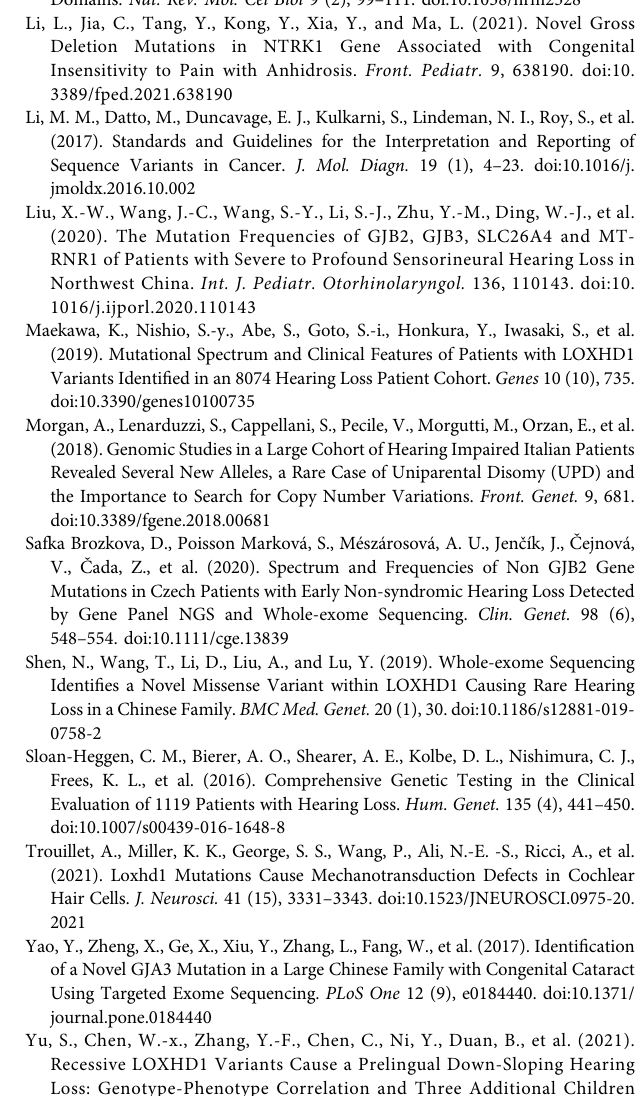
Supplementary Figure S1 | Scatter plots of hearing phenotypes of 21 patients after grouped by variant location and variant severity. Type1: grouped by variant location; Type2: grouped by variant severity. Supplementary Figure S2 | Proportions of different types of variation of LOXHD1 both worldwide and in China. (A) Proportions of different types of variation of LOXHD1 worldwide. Types of variation were broken down as missense, nonsense, frameshift,splice-site,intronicand synonymous. (B) Proportionsofdifferenttypesof variation of LOXHD1 in China. Types of variation were broken down the same as those in Panel (A) . (C) Stacked bar chart of different types of variation of LOXHD1 in China vs.